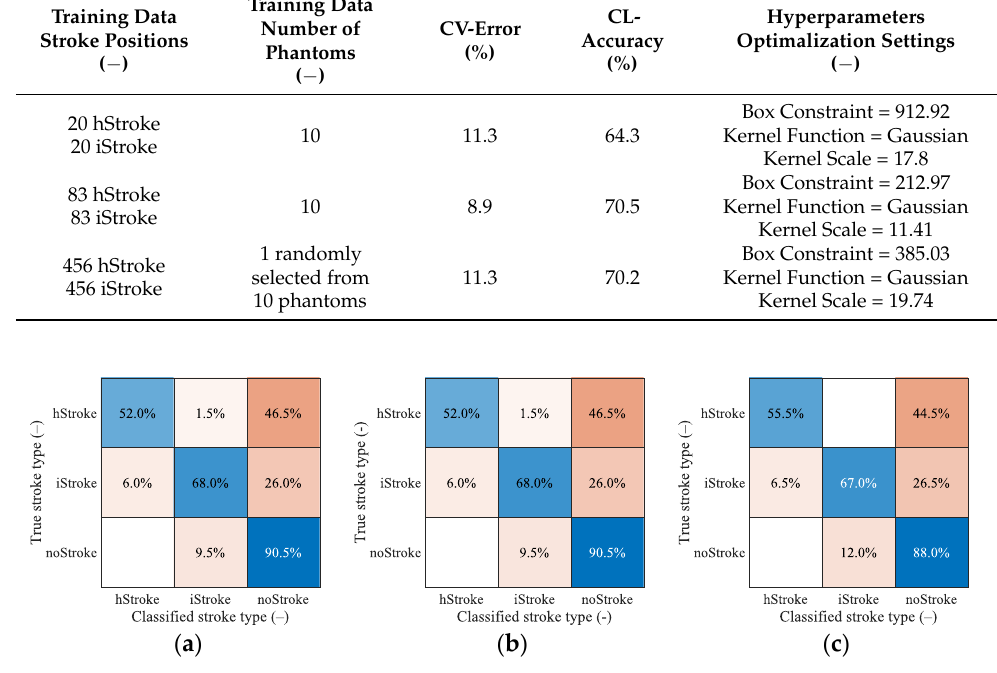
Figure 9. The confusion matrixes for classification of random stroke sizes and random stroke positions. In total, 200 samples for iStroke, 200 samples for hStroke and 200 samples for noStroke. SVM algorithm was trained for ( a ) 20 and ( b ) 83 ischemic and hemorrhagic strokes in 10 scaled phantoms and ( c ) for 456 ischemic and hemorrhagic strokes in 1 randomly selected phantom from 10 scaled phantoms.